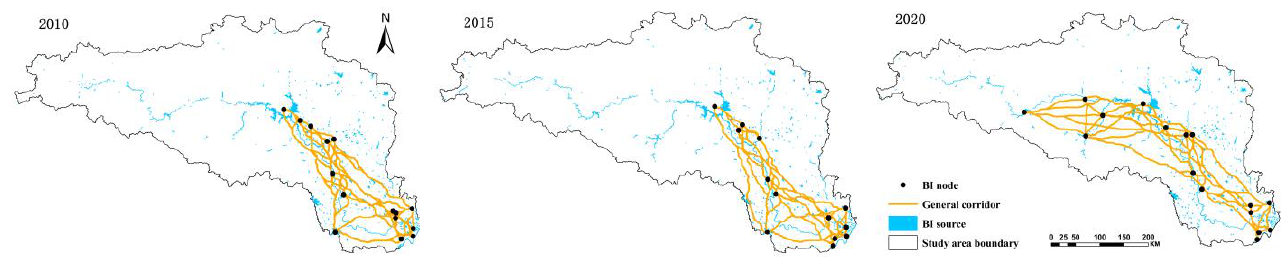
Figure 4. BI corridors of the study area.